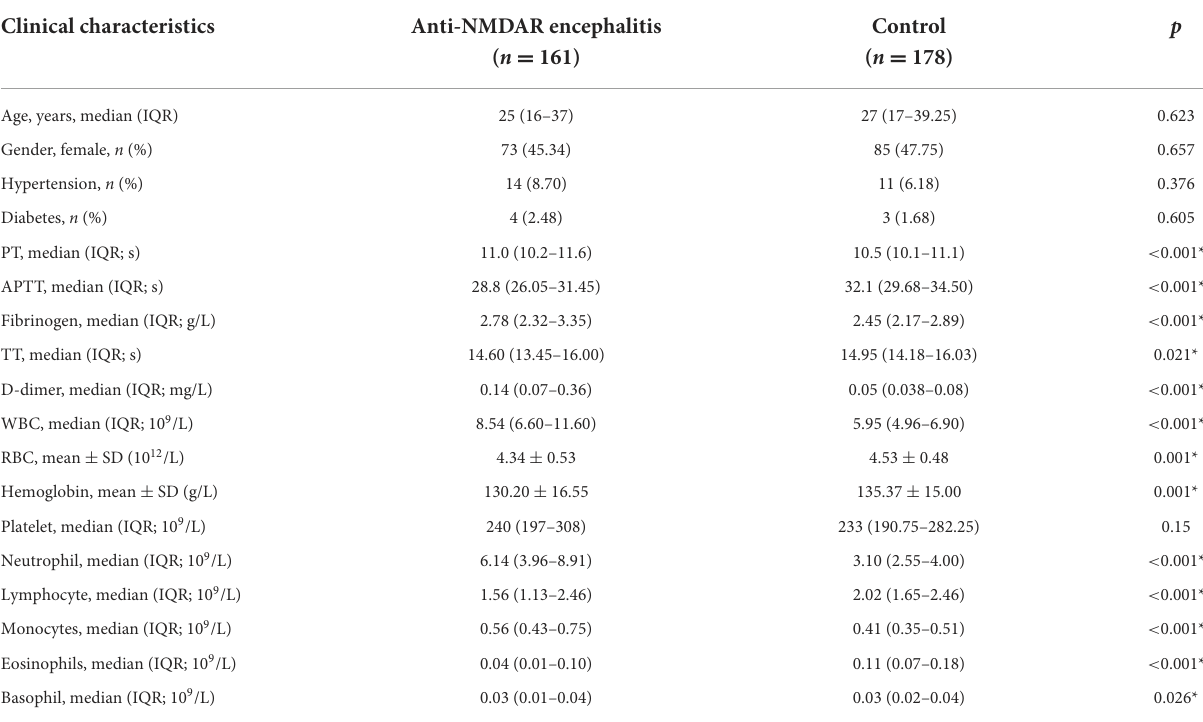
TABLE 1 Clinical characteristics of the patients with anti-NMDAR encephalitis and healthy